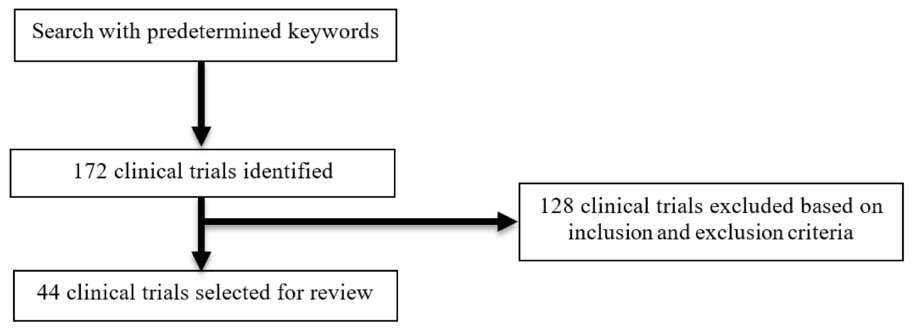
Figure 2. Literature review methodology.